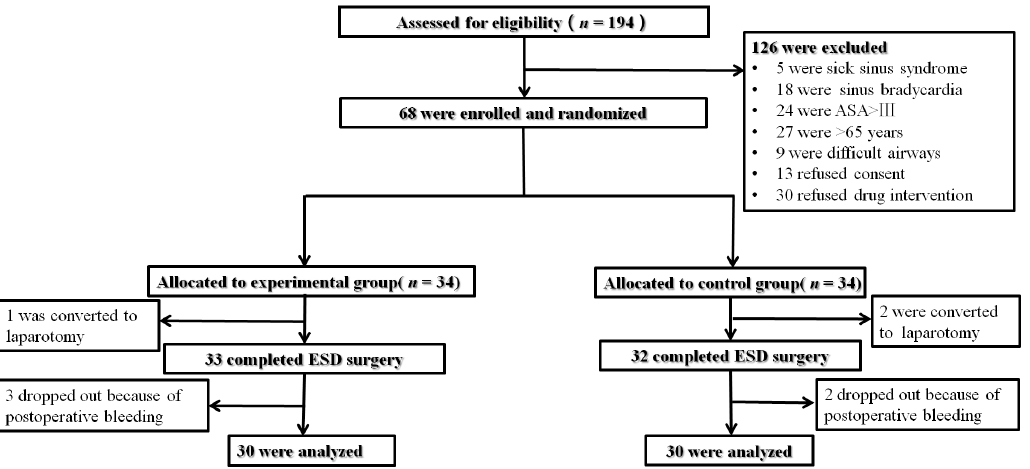
Figure 1. The flow chart of included and excluded patients. ASA: American Society of Anesthesiol- ogists; ESD: endoscopic submucosal dissection. Table 1. Demographic data and clinicopathological characteristics of included